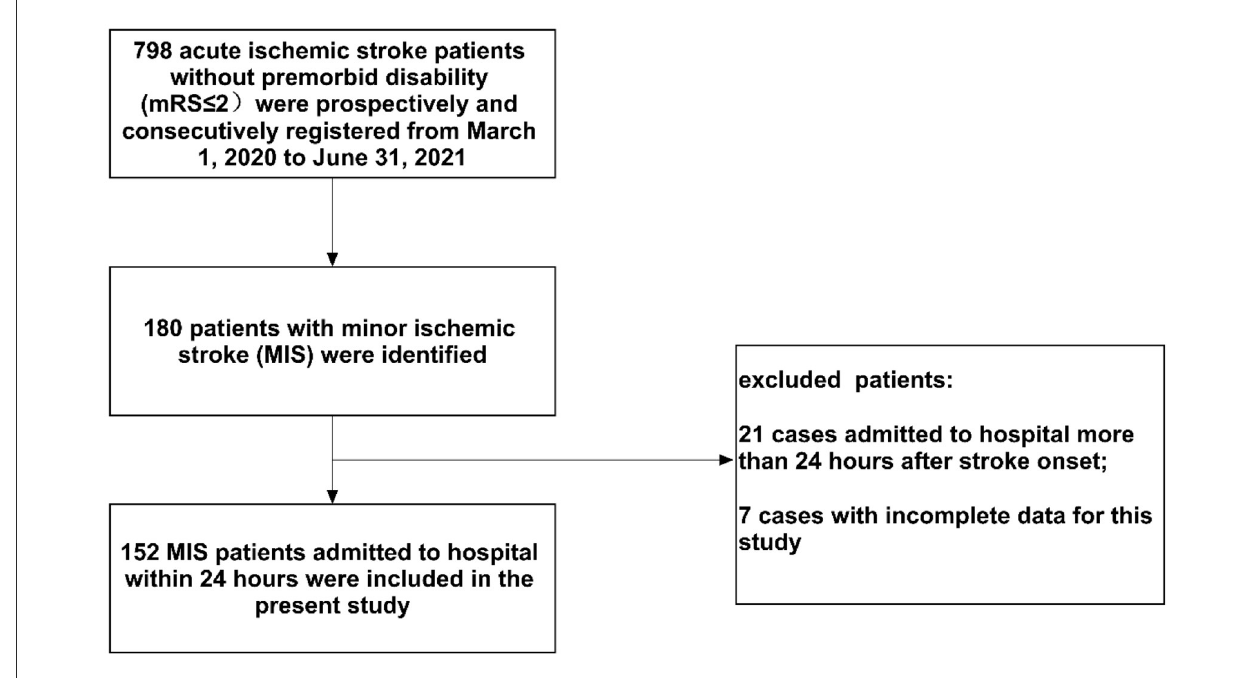
FIGURE1 Flow diagram of included and excluded